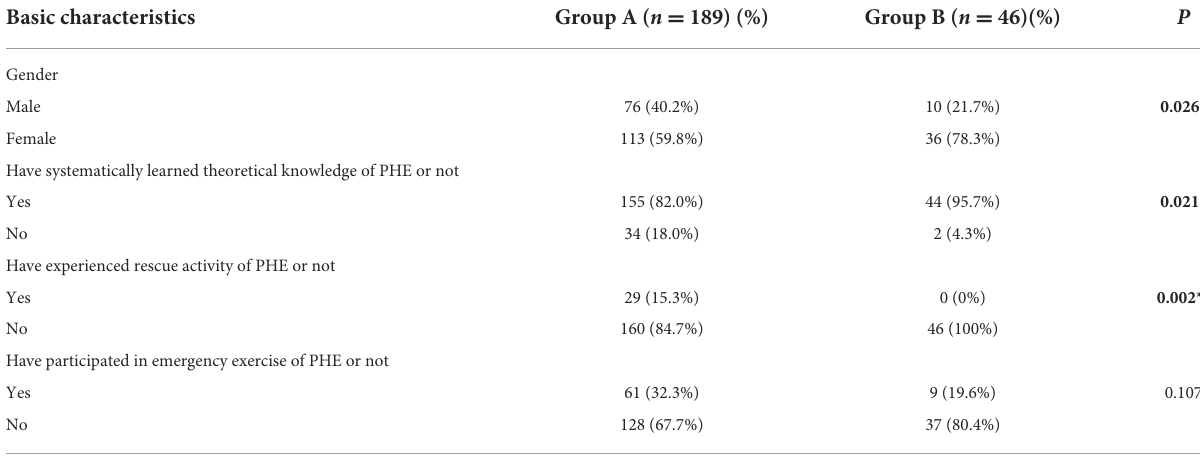
TABLE 1 Demographic characteristics and basic information of the involved clinical and preventive medical students. Basic characteristics